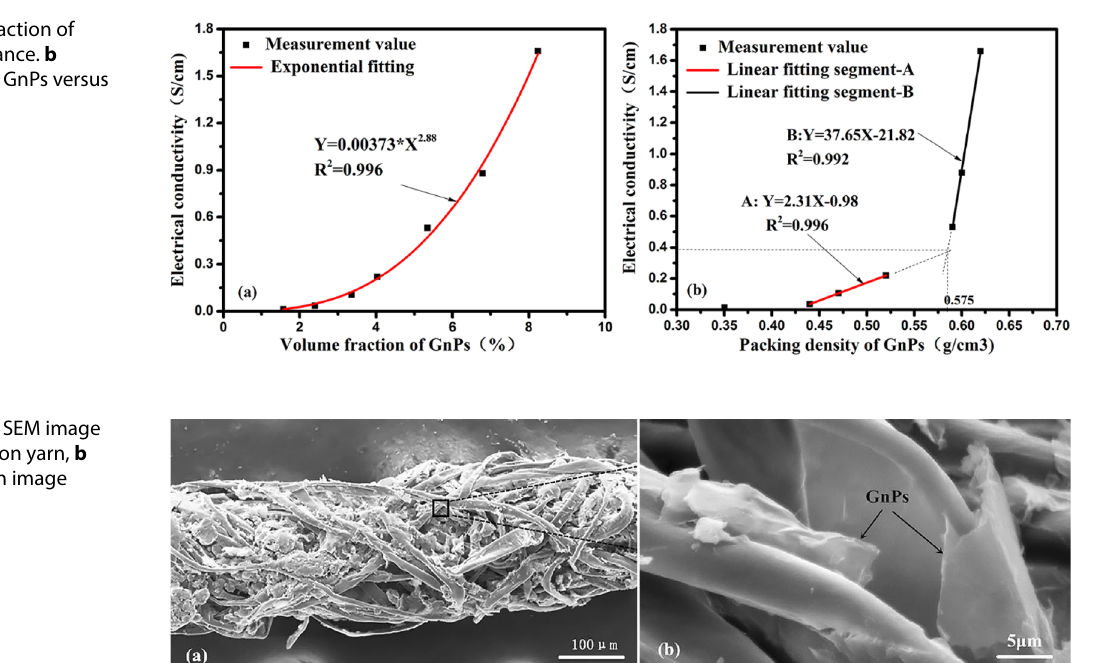
Fig. 1 a Volume fraction of GnPs versus resistance. b Packing density of GnPs versus resistance